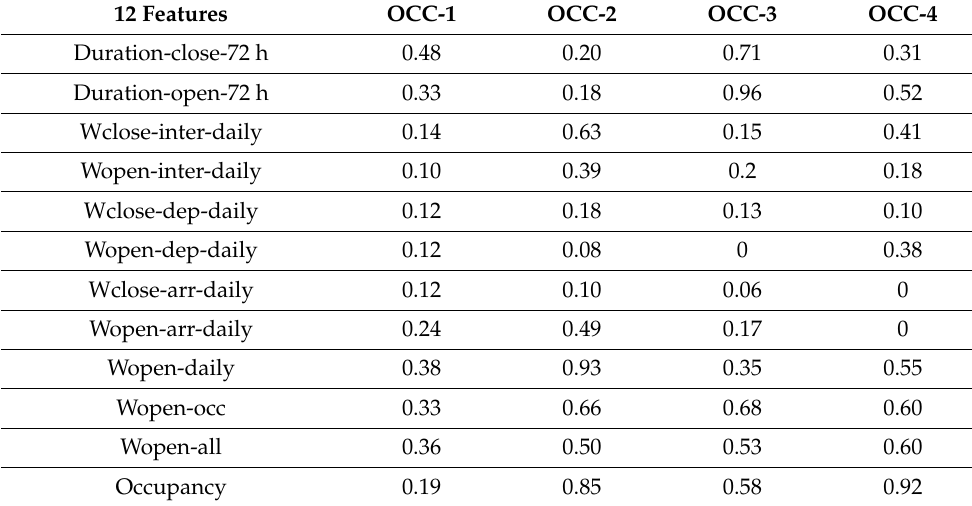
Table 3. The 12 features for window opening